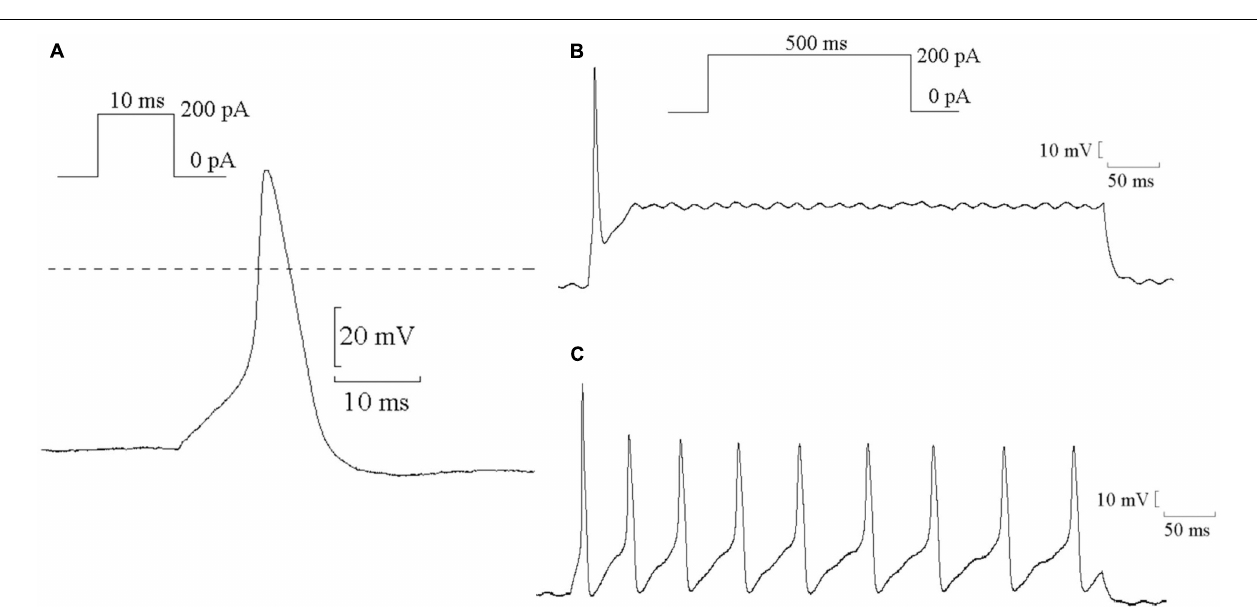
FIGURE 5 | Typical examples of AP in SCG neurons. (A) Typical examples of single AP of SCG neurons were elicited by positive current 200 pA for 10 ms. (B) Typical examples of single AP were elicited by positive current 200 pA for 500 ms. (C) Typical examples of continuous AP were elicited by positive current 200 pA for 500